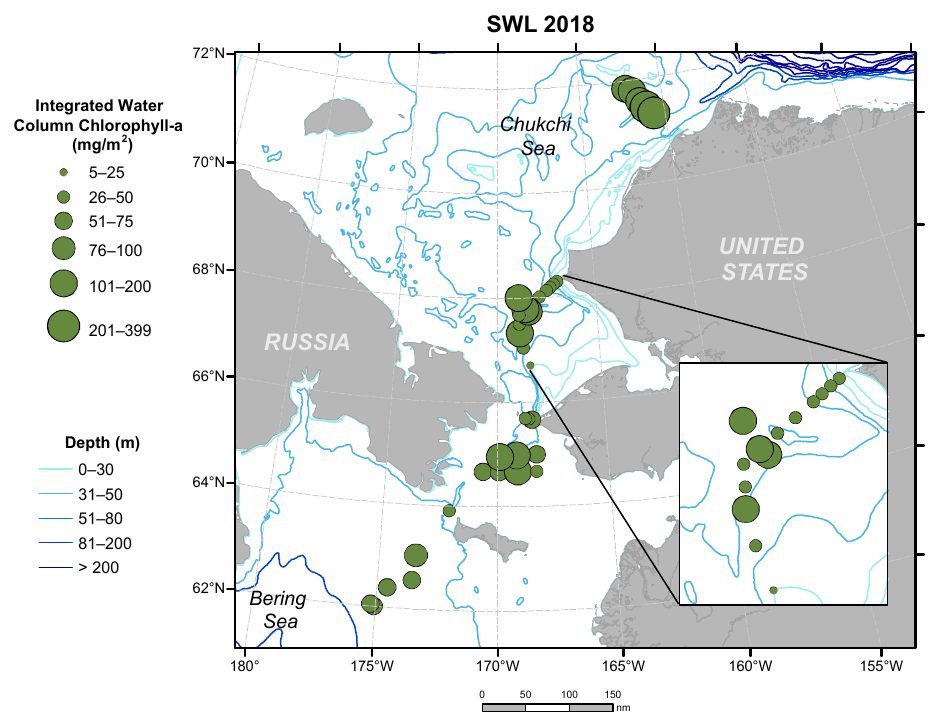
Figure 5. Spatial variation in integrated chlorophyll over whole water column during July 2018 CCGS Sir Wilfrid Laurier (SWL 2018) cruise.